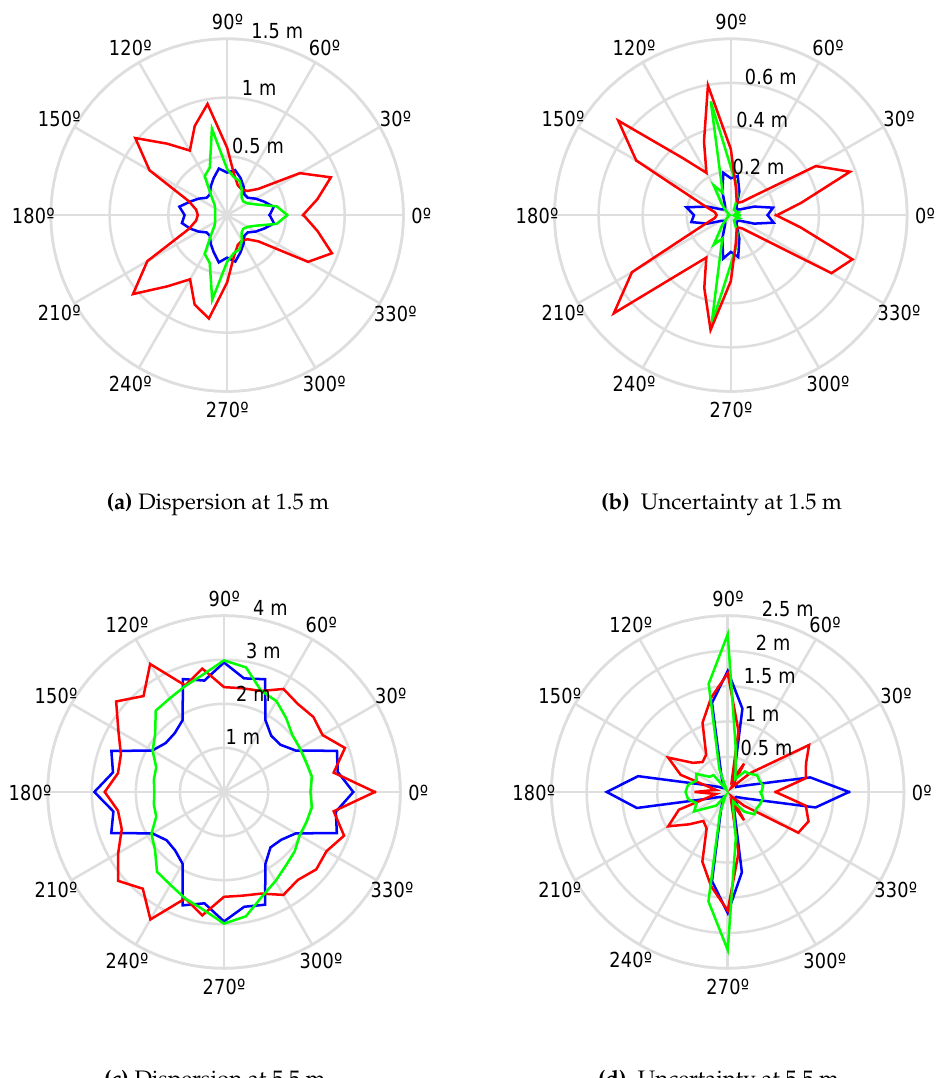
Figure 2. Simulation results for the three antenna layouts and the source located in circumferences with radii of 1.5 and 5.5 cm. The first column are the average dispersion of the solutions and the second column are the uncertainties of the average of the solutions. The layout in square is represented in blue, the star in red and the trapezoid in